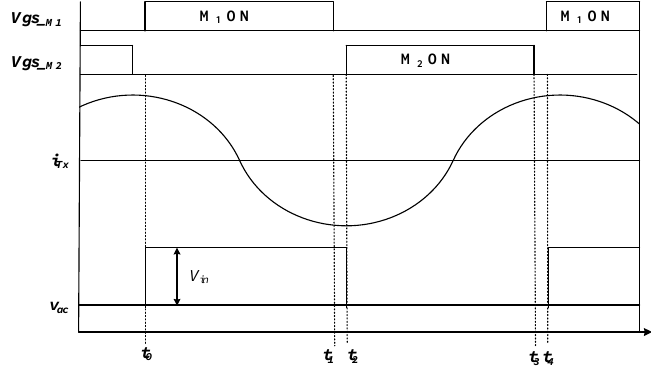
Figure 3. Simple operational waveform in the LC resonance operation.